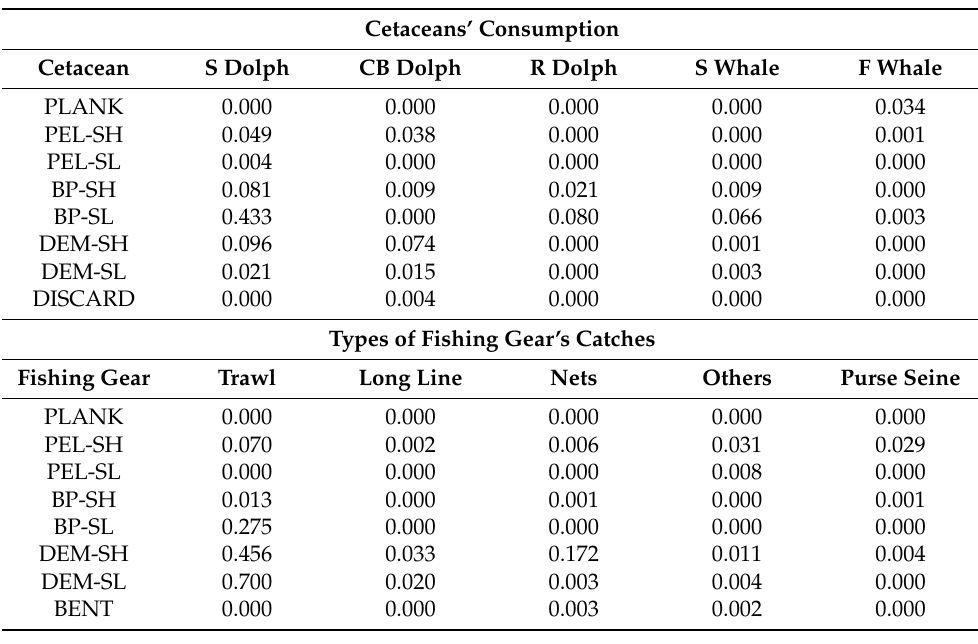
Table A4. Cetaceans’ consumption (t km − 2 year − 1 ) and different types of fishing gear’s catches (t km − 2 year − 1 ) on marine domains in the Gulf of Taranto